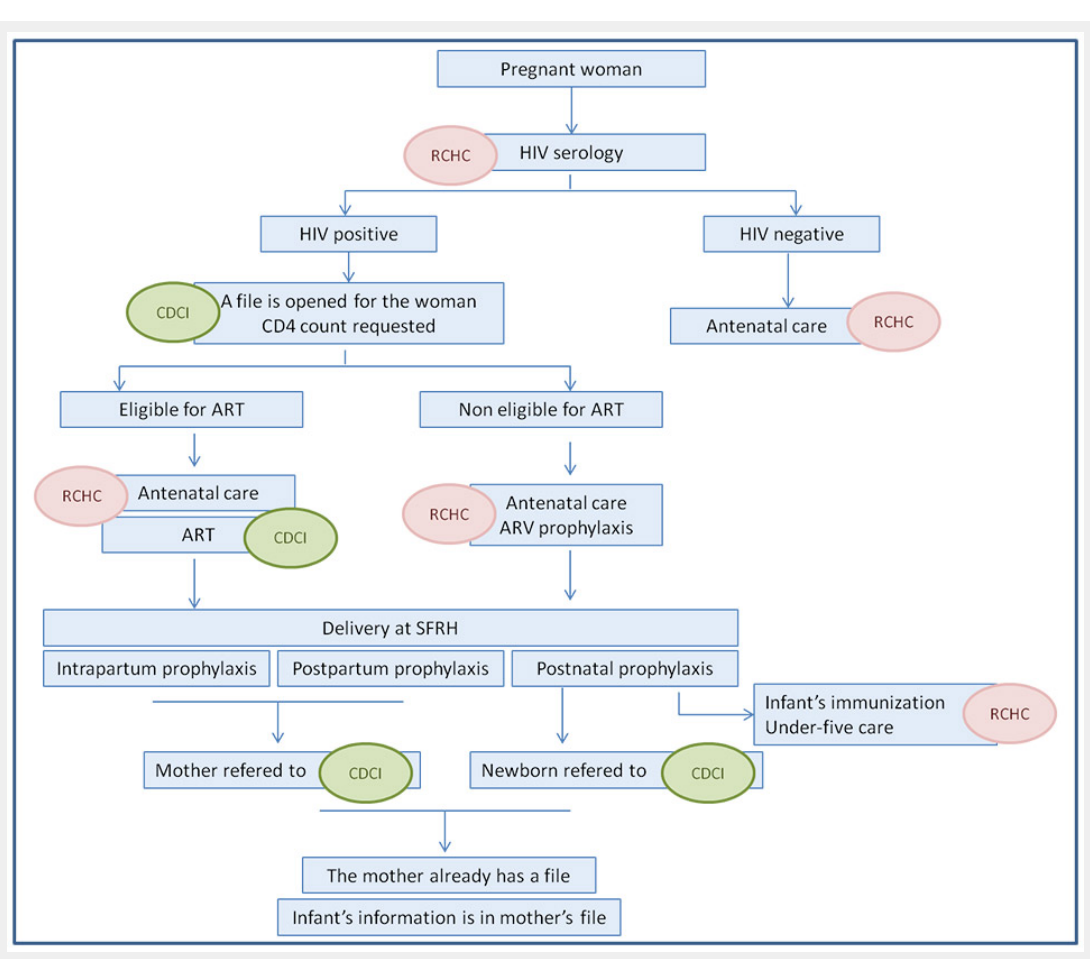
Figure 1 Theoretical care pathway for prevention of mother-to-child transmission (PMTCT) of human immunodeficiency virus (HIV) at St Francis Referral Hospital (SFRH). RCHC = Reproductive and Child Health Clinic; CDCI = Chronic Disease Clinic of Ifakara; ART = antiretroviral therapy; ARV =